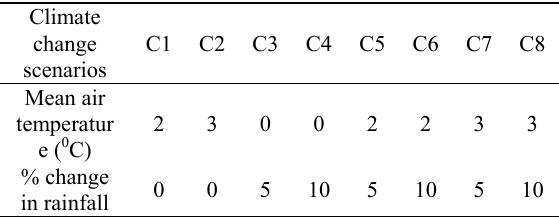
Table 2. Selected future climate change scenarios for the upper Beas basin